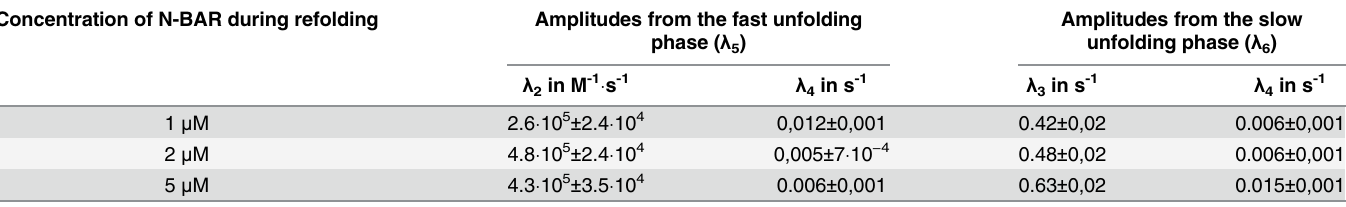
Table 2. Summary of refolding rate constants obtained from the double-mixing N assay. Concentration of N-BAR during refolding Amplitudes from the fast unfolding